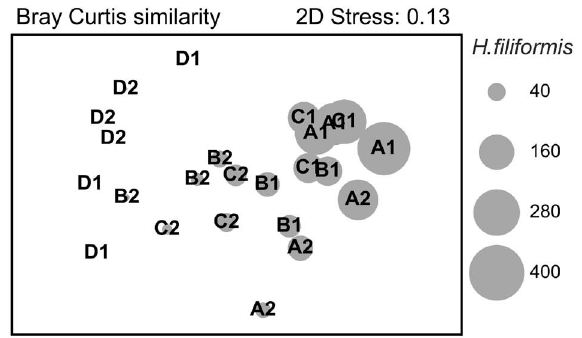
Fig . 6. – nMDS ordination of the whole assemblages in July (A1, B1, C1, D1) and January (A2, B2, C2, D2). The abundance of Heteromastus filiformis is superimposed on the ordination plot. The diameter of bubbles is proportional to the number of individuals per